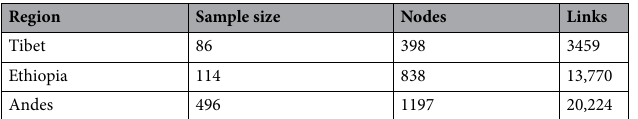
Table 1. Co-mutation networks: the number of nodes and connections in largest connected